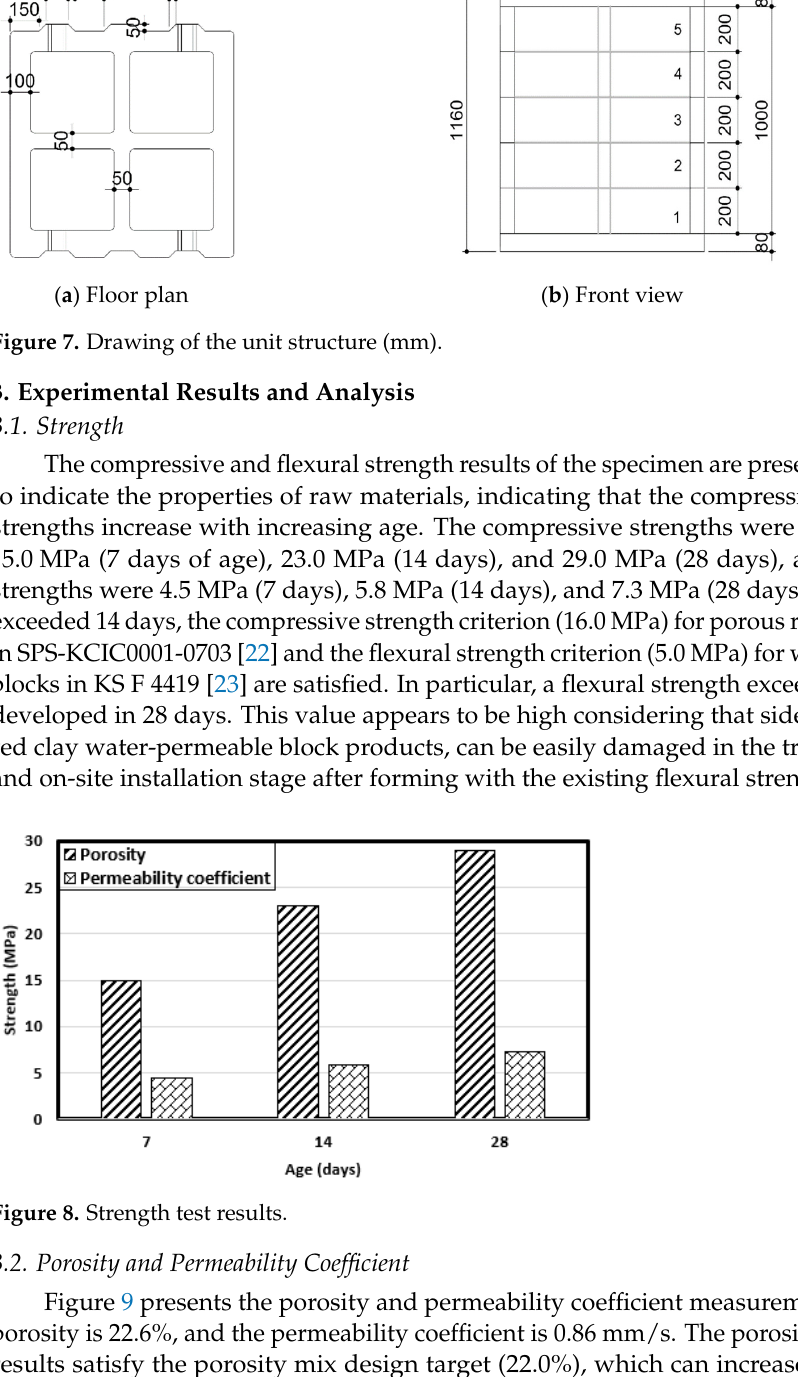
Figure 8. Strength test results.